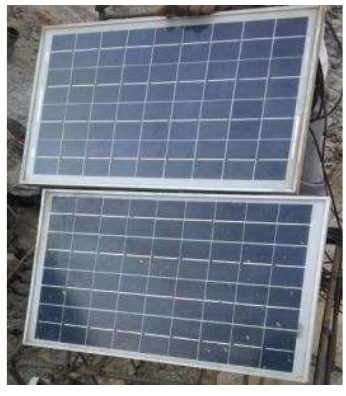
Figure 5. Solar panel.